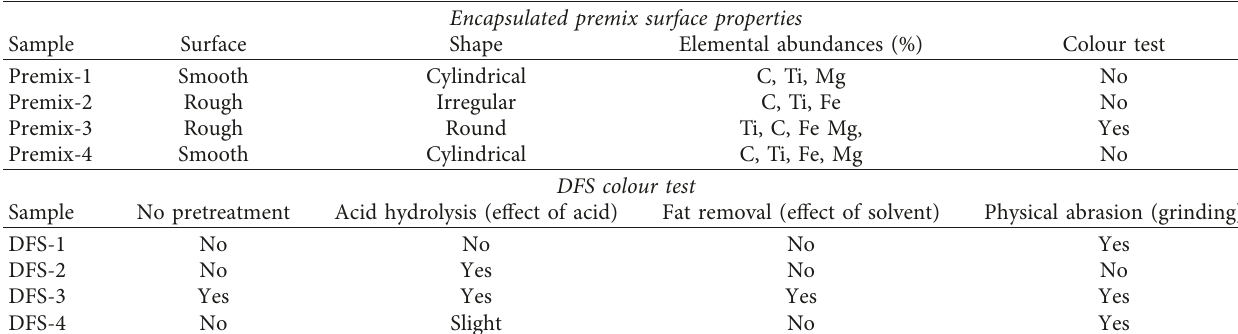
Table 3: Comparison of encapsulated premix surface properties, iron release, and qualitative iron colour test in the premix and double fortified